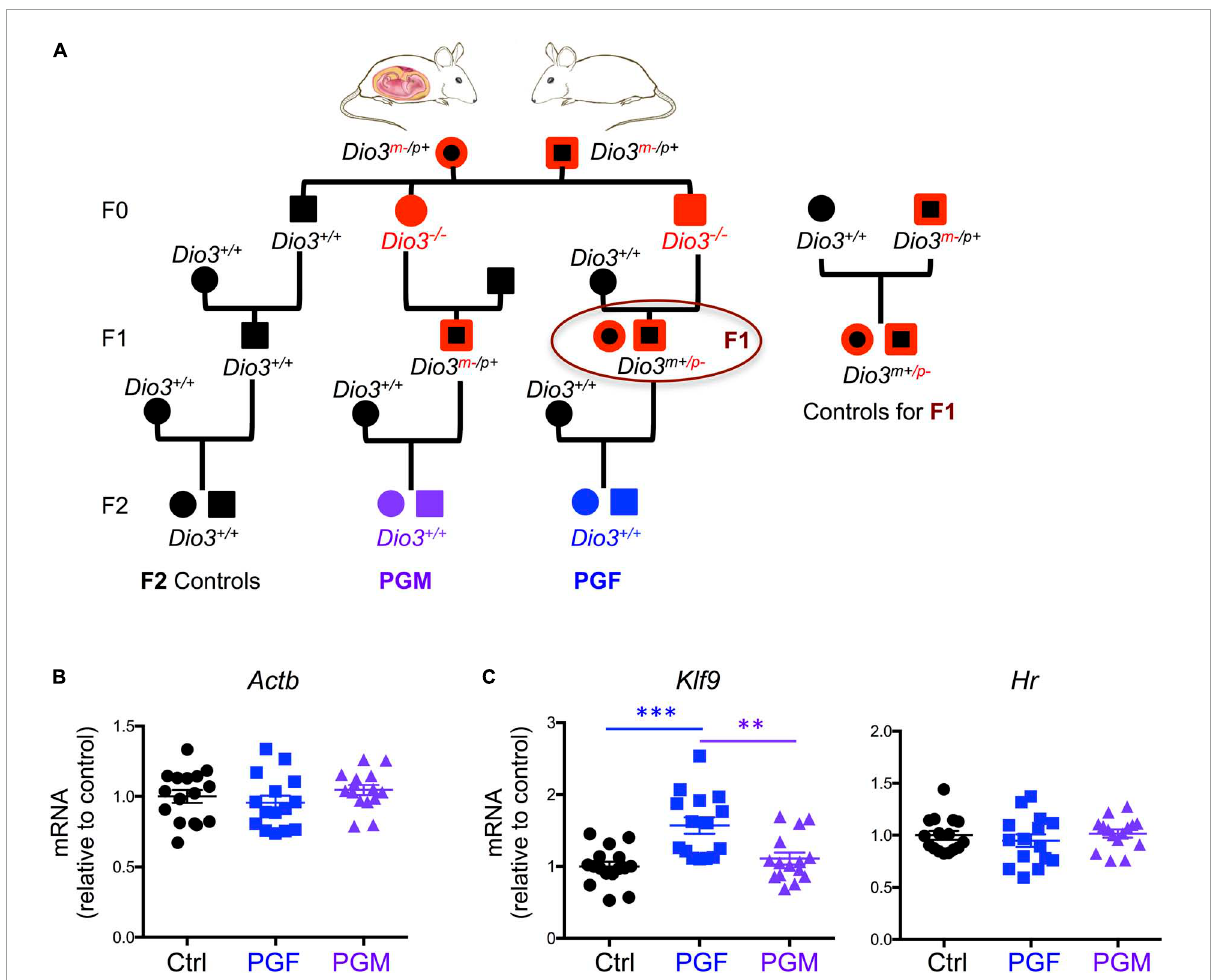
FIGURE1 Ancestry tree of the experimental animals and E13.5 brain gene expression of T3 regulated genes. (A) Ancestry of experimental animals studied that were F1 and F2 generation descendants of animals that were overexposed to thyroid hormone during development ( Dio3 − / − mice, in red). PGM and PGF indicate genetically normal animals with a paternal grandmother or paternal grandfather, respectively, overexposed. (B) Expression of the housekeeping gene Actin b . (C) Expression of T3 responsive genes Klf9 and Hr . Each point represents a different embryo ( n = 16, 15, 15) and mean ± SEM are shown. Experimental embryos represent 3–4 different litters. ** and *** indicate P < 0.01 and 0.001, respectively, as determined by ANOVA and Tukey’s post-hoc